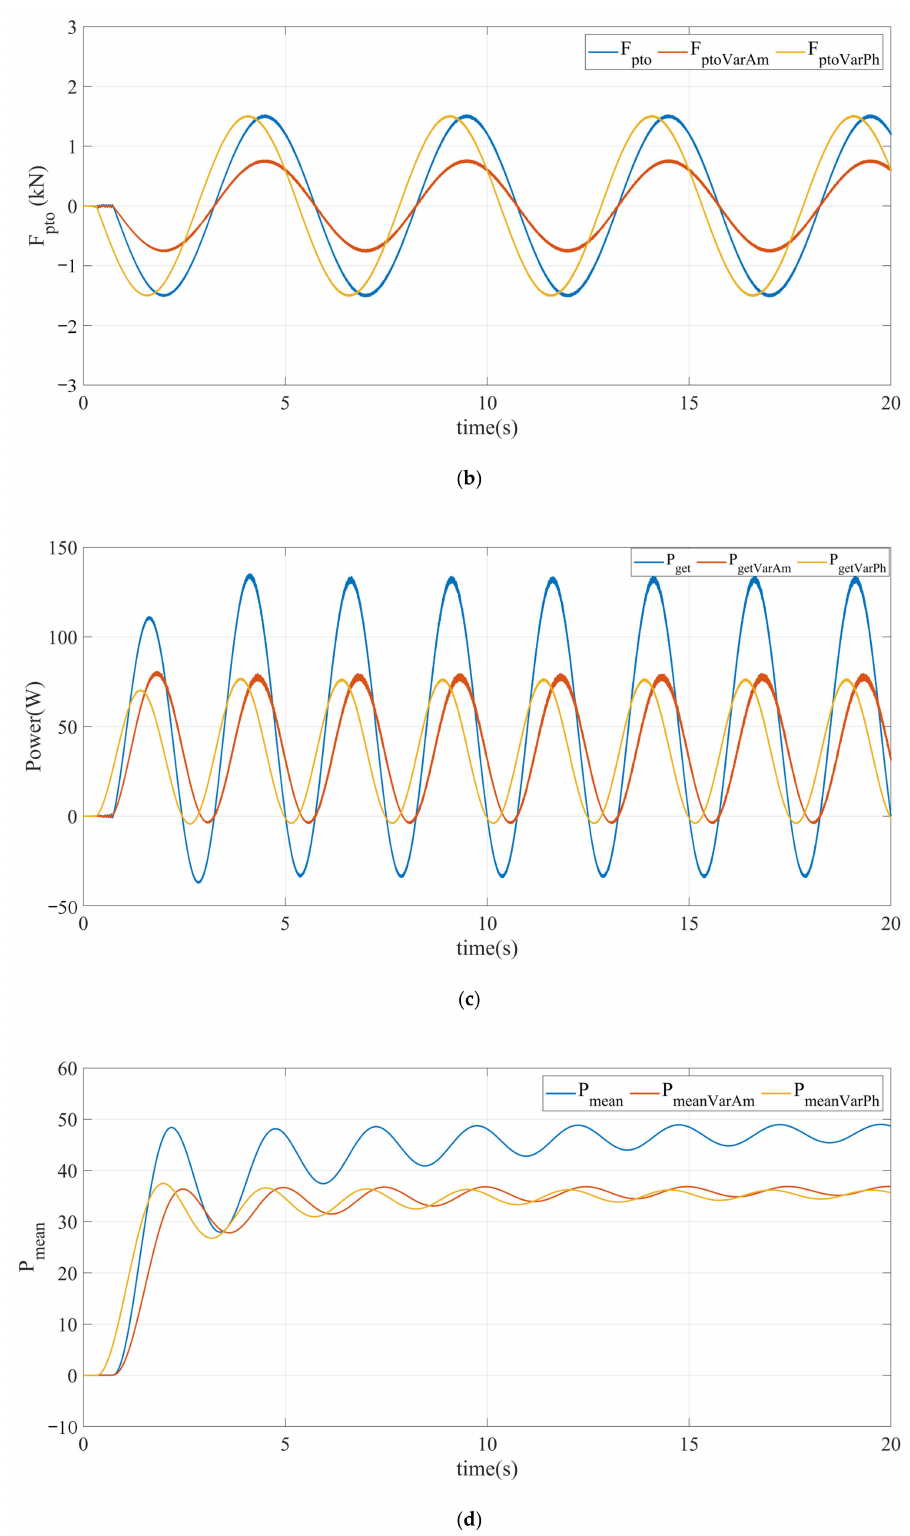
Figure 12. Electrical and mechanical dynamic response at different reference: ( a ) Q -axis current of generator at different reference; ( b ) Force in generator at different reference; ( c ) Power capture in generator at different reference; ( d ) Mean power capture in generator at different